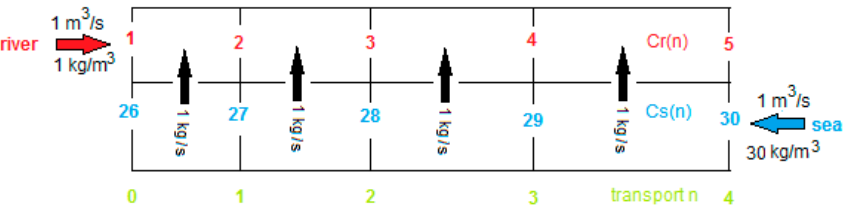
Figure 6. A RED stack with counterflow operation. Red numbers indicate salt concentrations in the river water compartment, blue in the seawater compartment. Transport parameter is given in green.